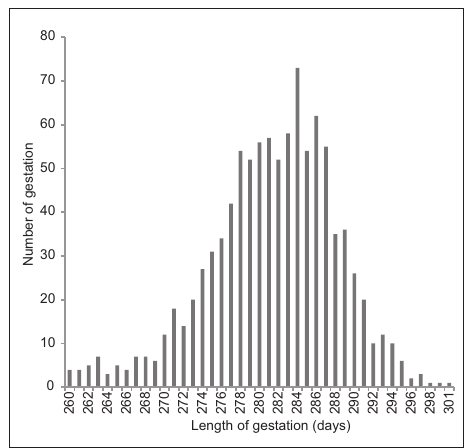
Figure-1: Frequency distribution of gestation length in Jersey crossbred cattle.